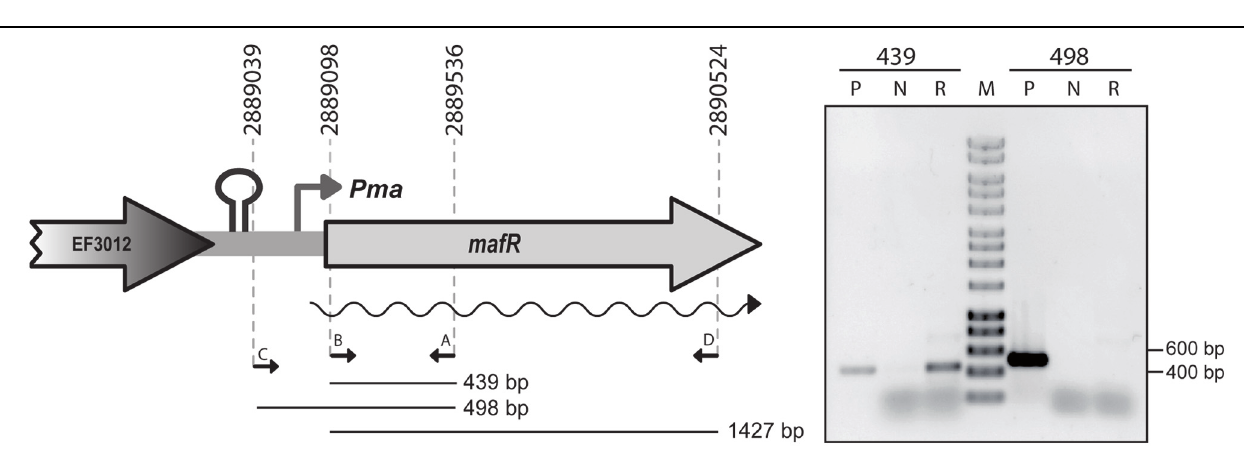
FIGURE 1 | Genetic organization of the mafR (locus_tag EF3013) region in the Enterococcus faecalis V583 genome. The coordinates of the predicted start and stop codons are shown. The nucleotide sequence of the region spanning coordinates 2889098 to 2888965 is shown. The stop codon (TAG) of EF3012 and the start codon (ATG) of mafR are indicated in boldface letters. The transcription start site ( + 1 position) of the mafR gene, and the main sequence elements (–35 box and –10 box) of the Pma promoter identified in this work are indicated. IR: inverted-repeat.